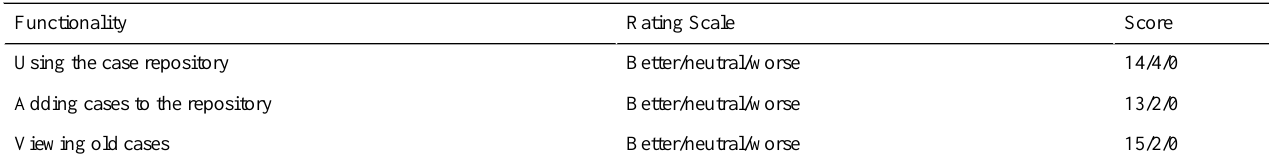
Table 1. Users’experience of SOMWeb’s functionality compared to the previous form of collaboration (These questions were answered by the 20 out of the 24 respondents who indicated that they had participated in SOMNet with PowerPoint support. Out of these 20, several did not answer all questions.) ScoreRating